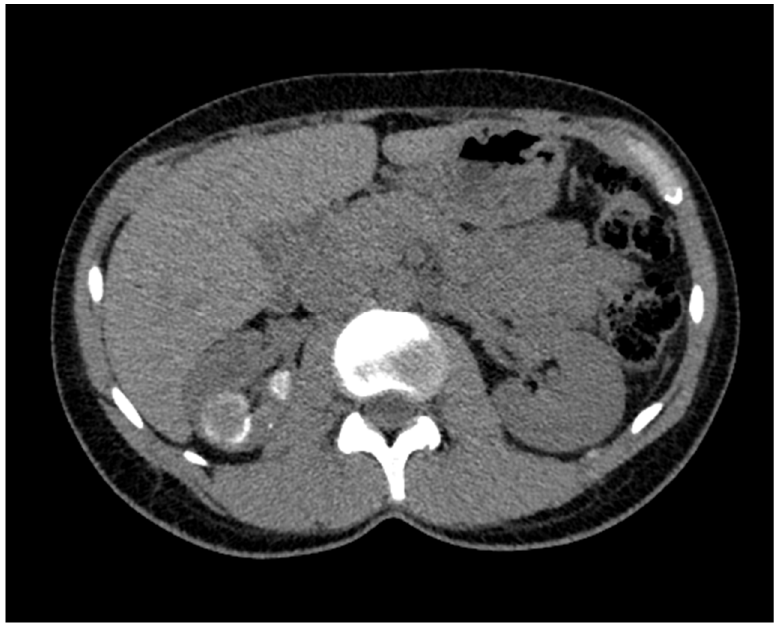
Figure 2. CT Scan image showing right upper pole kidney TB lesions—transversal view.